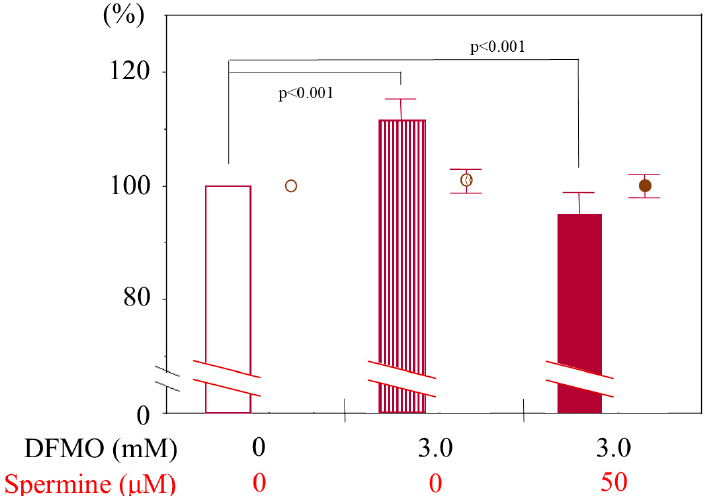
Figure A1. Changes in LFA-1 expression and cell viability of Jurkat cells cultured with DFMO and spermine. Expressions of CD11a and Viaprobe on Jurkat cells cultured for 72 h in various conditions were analyzed by flow cytometry. The values were relative to the control (cells cultured in unsupplemented culture medium). Data are shown as means and standard deviations. Bars indicate percentage of mean fluorescent intensities of twelve samples ( n = 12) in each culture condition. Circles indicate percentage of viable cells ( n = 3). DFMO (3mM) and spermine (500 µM) did not change cell viability. 3mM of DFMO for 3 days increased mean fluorescent intensity of CD11a, and spermine (500µM) with DFMO decreased LFA-1 expression without affecting cell viability. DFMO: D,L-alphadifluoromethylornithine-hydrochloride.